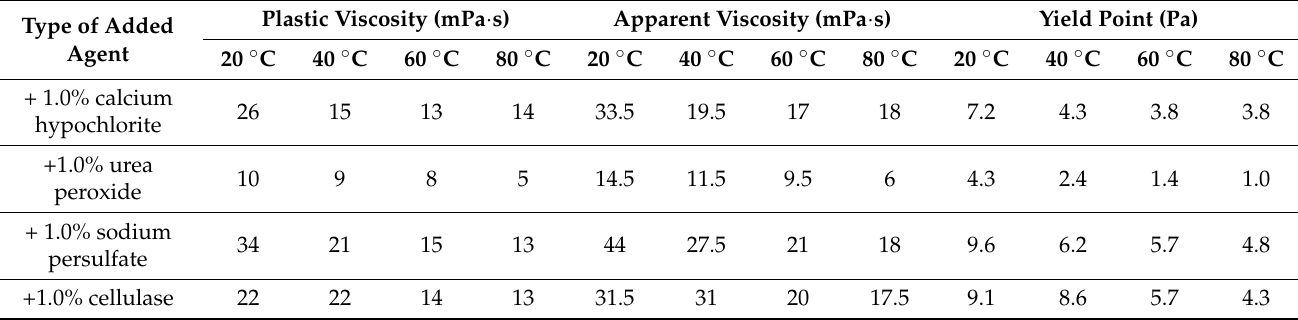
Table 6. The rheological parameters of salt-barite drilling mud C with thinning additives at various temperature values. Type of